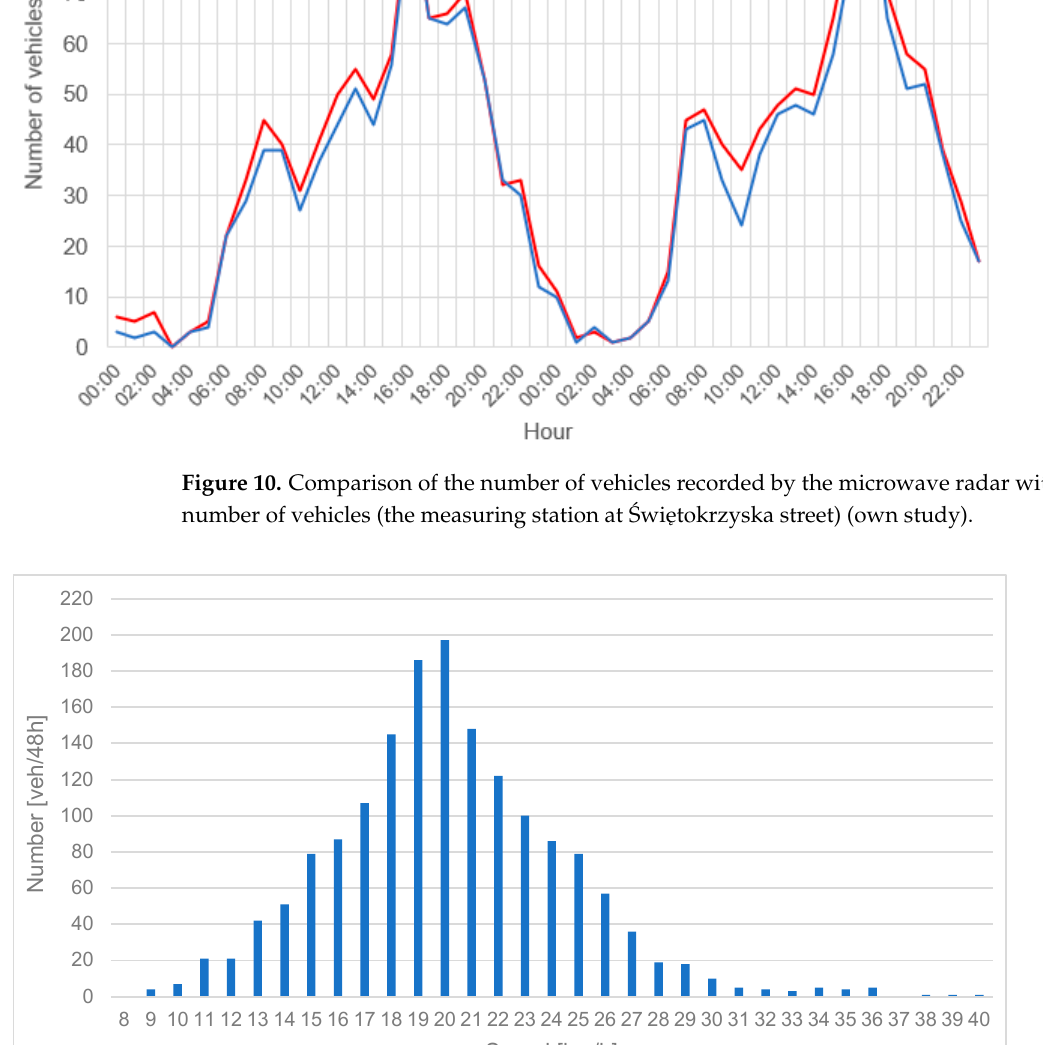
Figure 11. Distribution of vehicle speed in the bicycle lane along Ś wi ę tokrzyska street (own study).